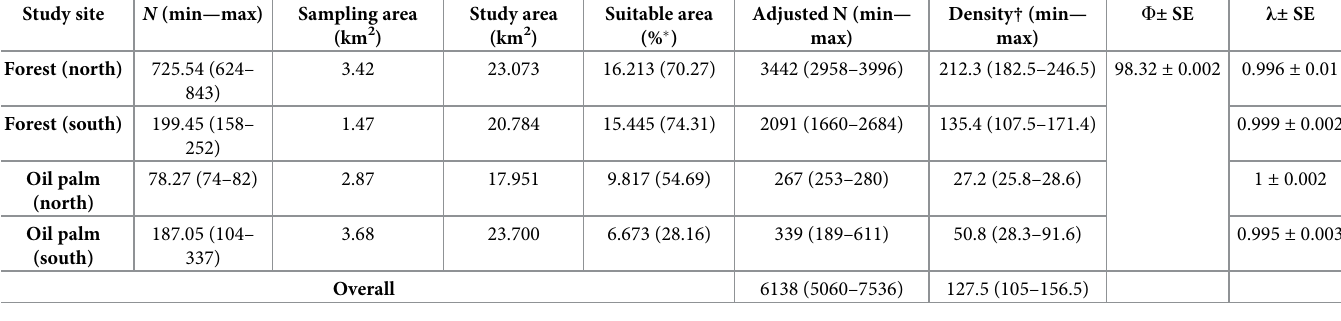
Table 1. Population size ( N ), survival ( F ) and growth ( λ ) rates of the Asian water monitor lizard in the Kinabatangan floodplain. Suitable area and adjusted N were estimated according to suitable habitats for the species distribution. Study